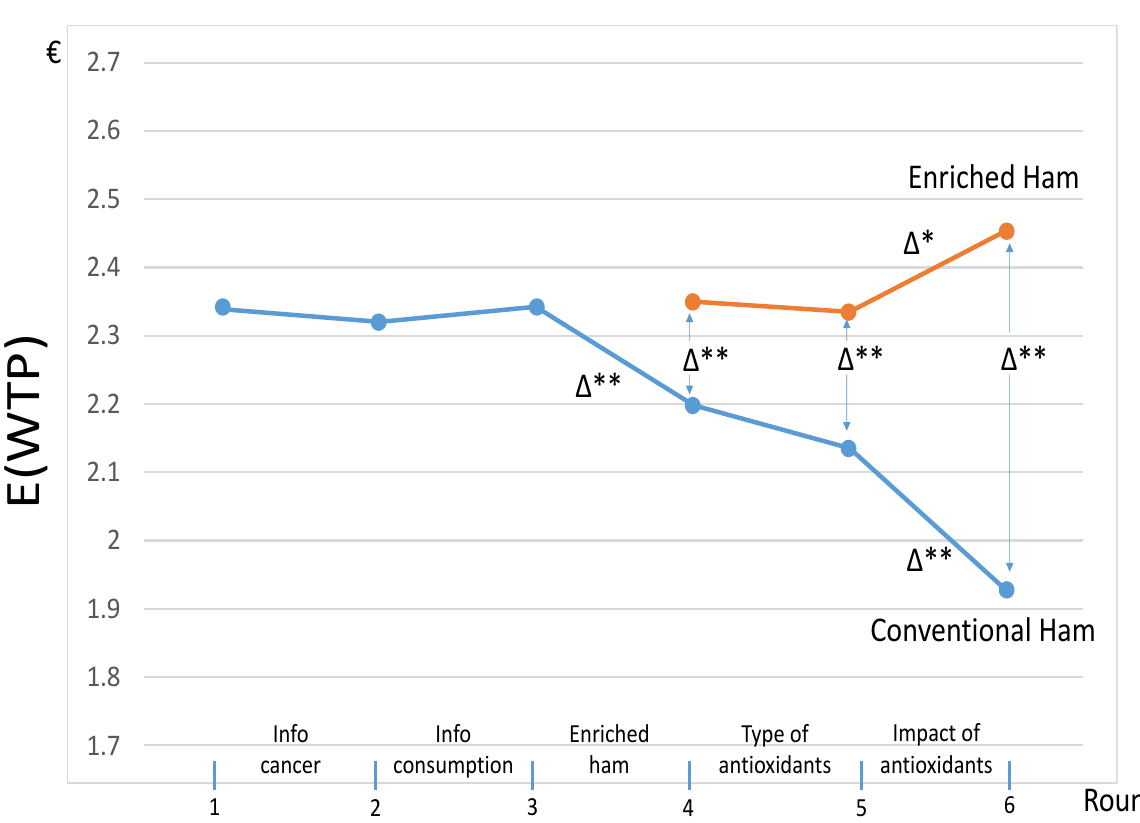
Figure 1. The average WTP for one packet of ham ( € ) and the influence of the messages. Note: 139 participants were taken into account. ∆ * denotes a significant difference at 5%, and ∆ ** denotes a significant difference at 1%, as tested by the Wilcoxon test for comparing paired sample choices. For each product with ∆ indicated above the corresponding line, we tested for significant differences in the WTPs elicited between two successive rounds R , with R = {1, . . . , 6} for the conventional ham and R = {4,5,6} for the enriched ham. For the same round with ∆ indicated between the points of different products, we tested significant differences between WTPC#4 and WTPE#4, WTPC#5 and WTPE#5, and WTPC#6 and WTPE#6 for the different rounds and for R = {4,5,6}.